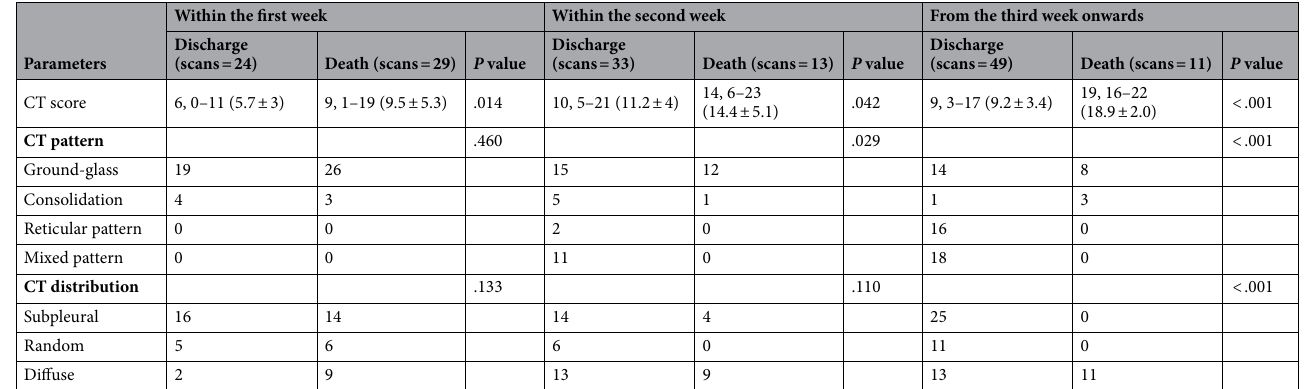
Table 2. Comparison of CT findings in discharge and death groups based on CT scans. Except where otherwise indicated, data are median and range (mean ± SD) of CT score or number of CT scans. One patient showed no any abnormalities on CT scan within the first